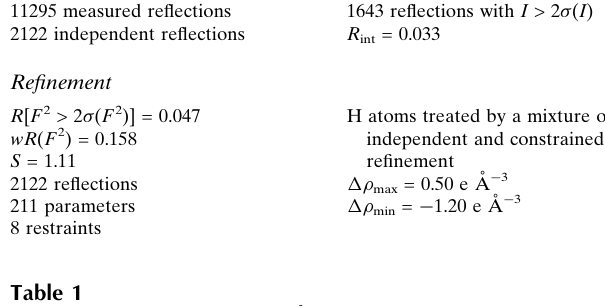
Selected geometric parameters (A˚ , (cid:4) ).